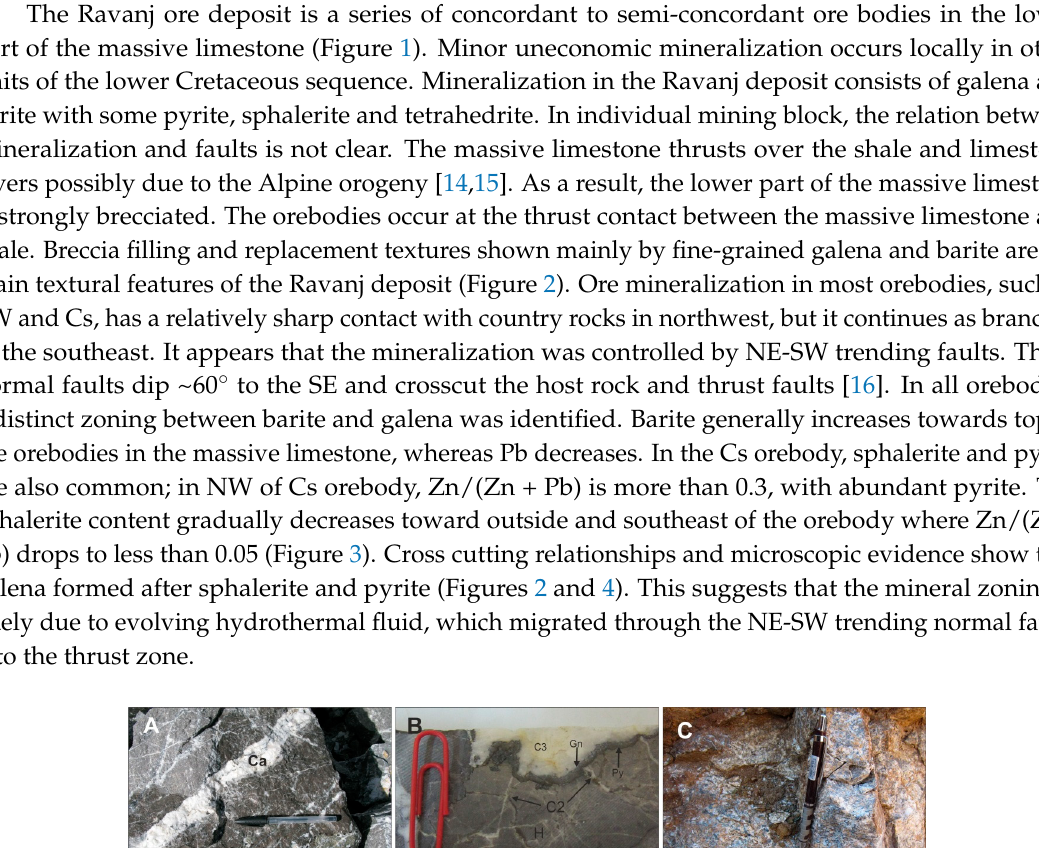
Figure 3. Schematic cross sections of the Cs ore body of the Ravanj deposit. Change in content of Pb (%) from the bottom to top of the massive limestone in the Csw03 drill hole (data from the Soojmiran Co. drill core loges).